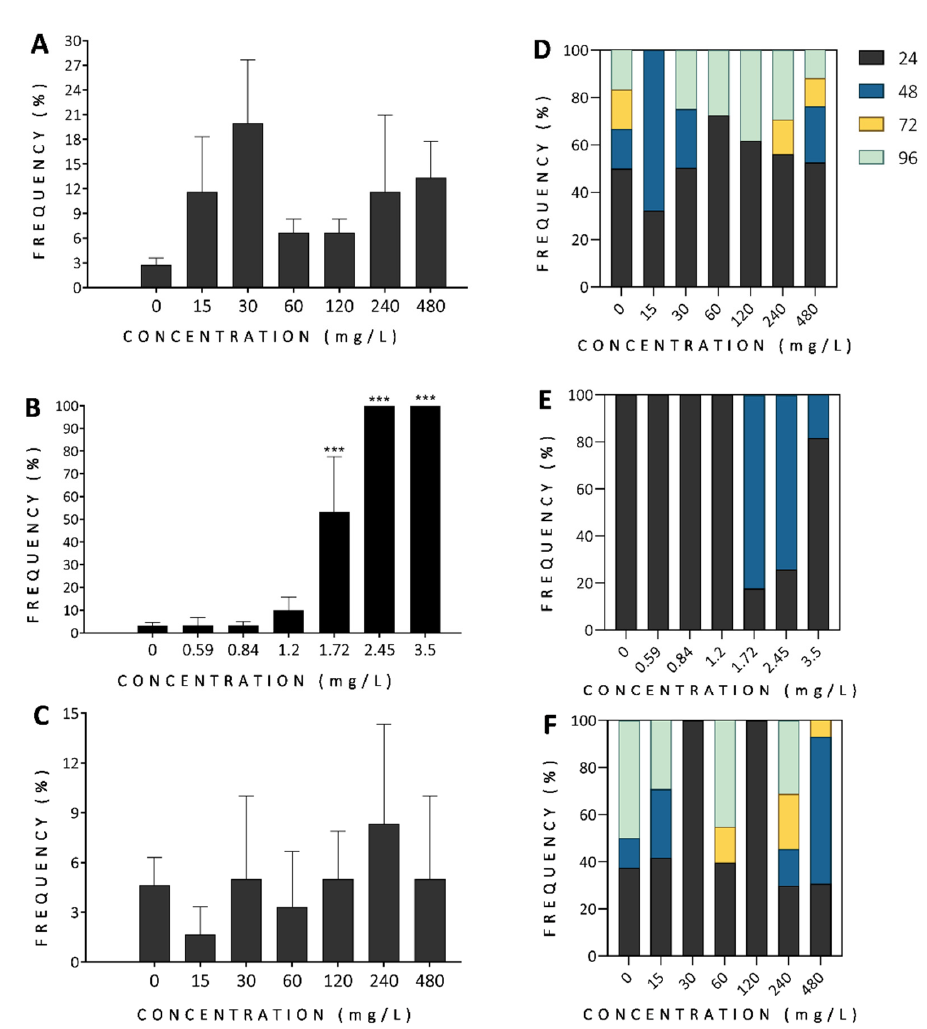
Figure 3. Phenotypic assessment of zebrafish development for the whole organism exposed 96 h post-fertilization to different concentrations of finger lime ( A , D ), mountain pepper ( B , E ), and tam- arind ( C , F ). Cumulative mortality observed at 96 h of exposure are shown in panel ( A ) for finger lime, ( B ) for mountain pepper, and ( C ) for tamarind. The mortality frequency observed at different experimental times of exposure is shown for finger lime ( D ), mountain pepper ( E ), and tamarind ( F ). The colours in ( D – F ) represent the age at which mortality was observed (in hours post-fertiliza- tion). Data show the mean ± SD, n = 60. Asterisks indicate statistical significance when compared to control groups: p < 0.001 (***).